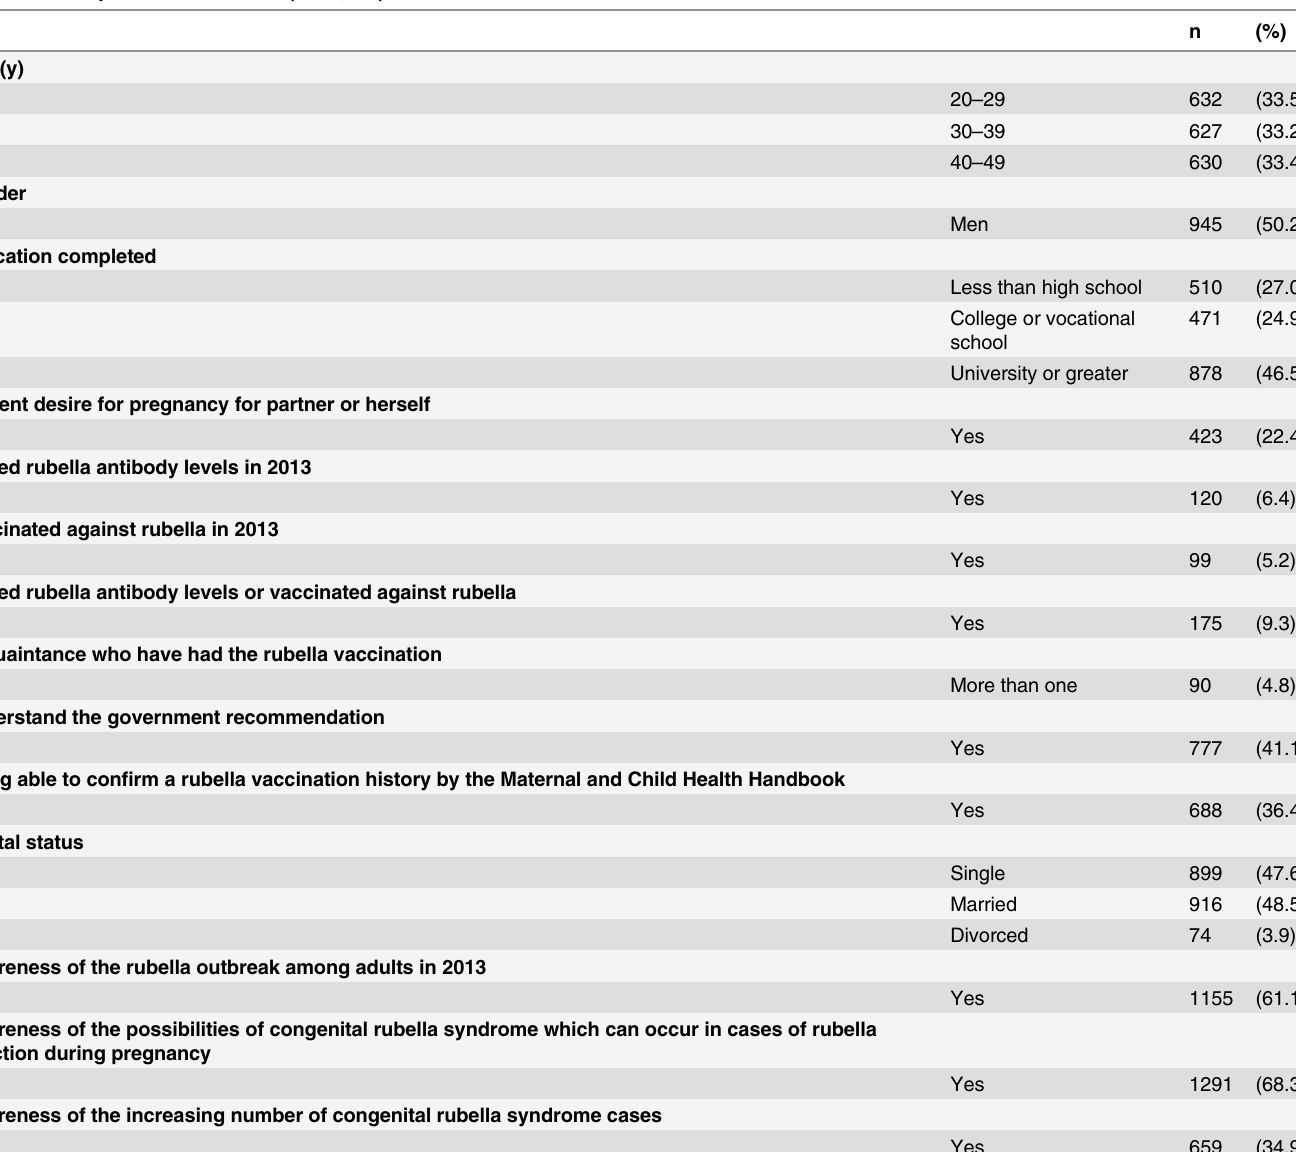
Table 1. Participant characteristics (N =